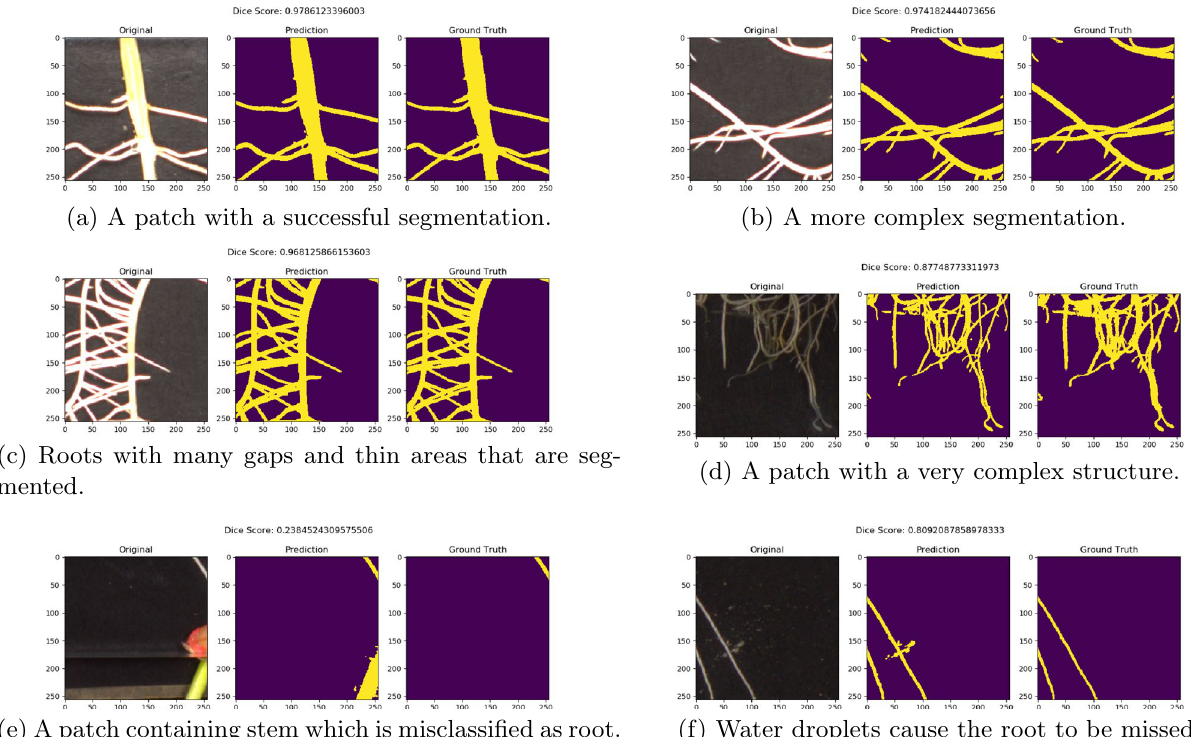
(e) A patch containing stem which is misclassified as root. (f) Water droplets cause the root to be missed. Figure 8. Input, prediction, and ground truth patches for the testing set on the best model found with hyper- parameter tuning. We can see that the root structure is retained with high detail, including fine gaps between roots which grow closely together ( a )–( d ). However, when non-root objects, such as plant stem in ( e ) or water droplets in ( f ), are present in the input, we see a degradation of segmentation quality.